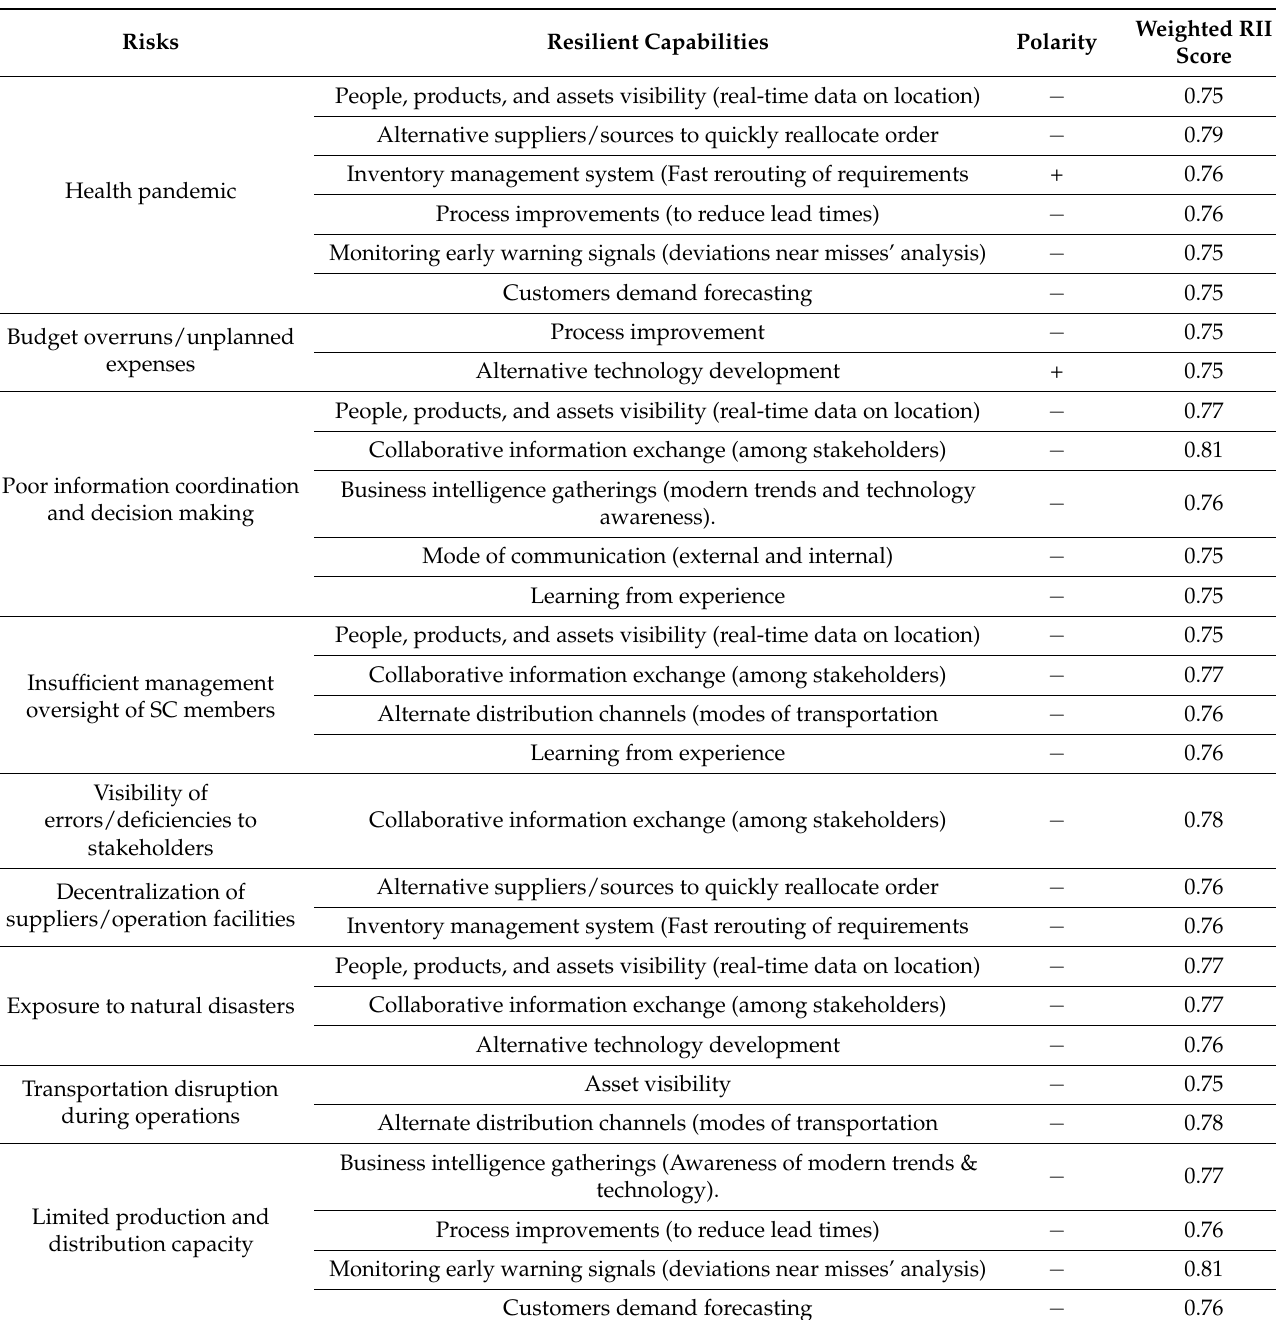
Table 4. RII score and polarity of shortlisted